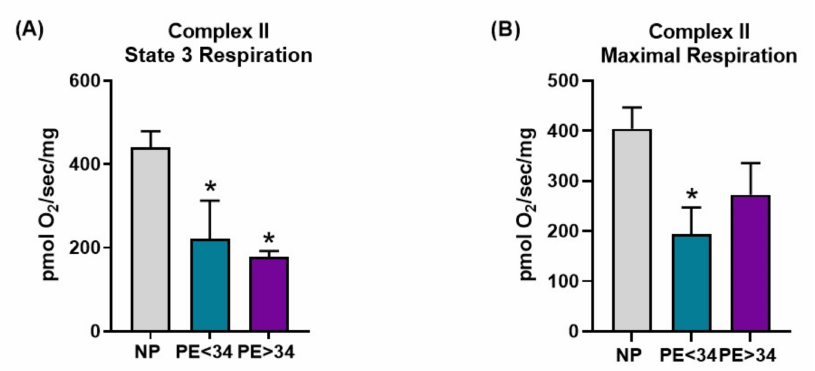
Figure 4. Complex II-mediated respiration in isolated mitochondria. Oxygraph-2K oxygen consump- tion assay showed Complex II mediated placental mitochondrial state 3 respiration was significantly reduced in both preeclamptic patients of both gestational ages (PE < 34 weeks, n = 4; teal bar and PE > 34 weeks, n = 5; purple bar) vs. normal pregnants (NP, n = 7; gray bar) ( A ). Further, placental mitochondrial maximal respiration was reduced in preeclamptic patients of early gestational age (PE < 34 weeks, n = 4) and showed a trend in towards reduction in preeclamptic patients of late gestational age (PE > 34 weeks, n = 5) vs. normal pregnants (NP, n = 7) ( B ). The results represent means ± SEM. * p < 0.05 vs. NP. pmol, picomoles; O 2 , oxygen, mg, milli grams, sec, second; SEM, standard error of